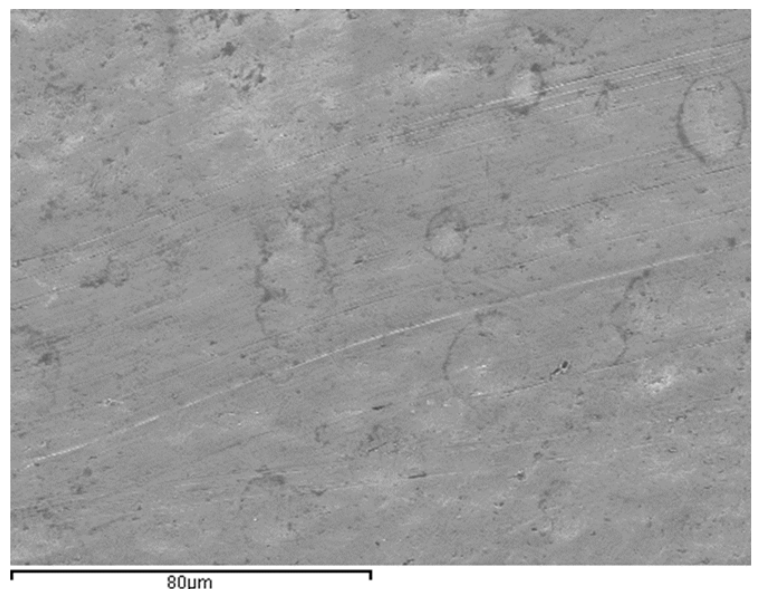
Figure 3. As-received NiTi orthodontic wire. The microstructure is completely austenite.